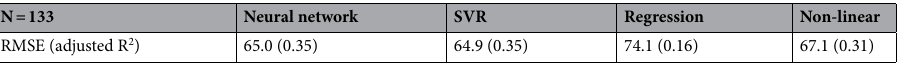
Table 5. RMSE of the 3-feature machine learning models regression task compared to the published non- linear equation. The PaO 2 was imputed using an online calculator of the three machine learning models using SpO 2 , PEEP, and FiO 2 from a validation cohort of 133 mechanically ventilated ICU patients. Subsequently, the RMSE and adjusted R 2 for the 3-feature machine learning models were calculated and compared to the published non-linear equation. A lower RMSE and higher adjusted R 2 indicate higher accuracy. SVR Support vector regression, RMSE root-mean-square deviation.